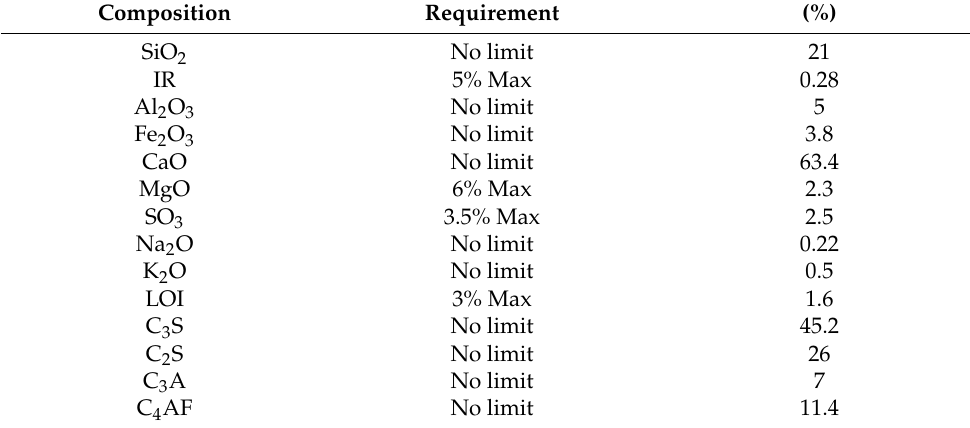
Table 2. Chemical characteristics of Portland cement using XRF technique [13,14].